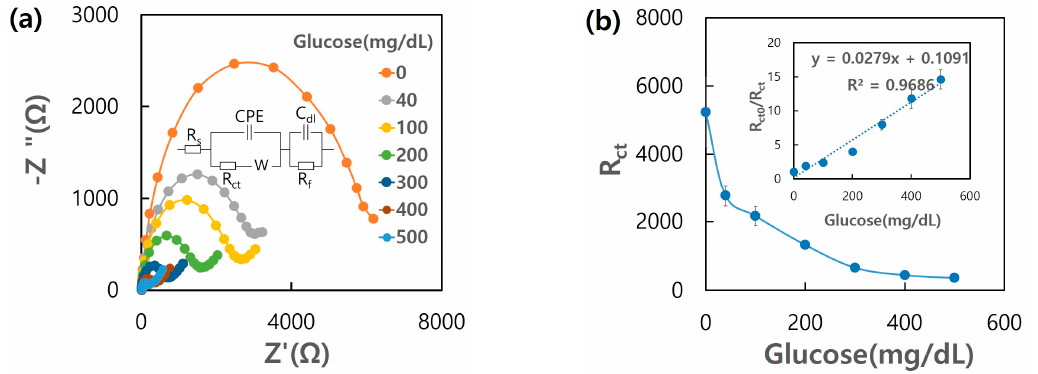
Figure 4. ( a ) Nyquist plots and ( b ) electron transfer resistances obtained applying 50 µL of 0.1 × PBS (pH 7.4) containing 10 mM Fe(CN) 6 3 − /4 − , 0.1 M KCl, and glucose in the range of 0–500 mg/dL to the DA-modified electrode. Inset in ( a , b ) is the equivalent circuit model and the relative electron transfer resistance respectively. R cto represents the electron transfer resistance without glucose.